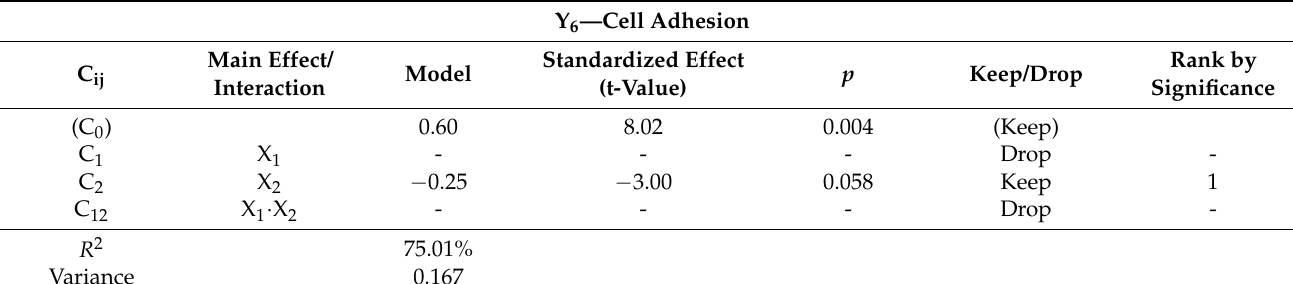
Table 8. Model in coded units for output variable Y 6 obtained by dropping terms with p -value > 0.1. Y 6 —Cell